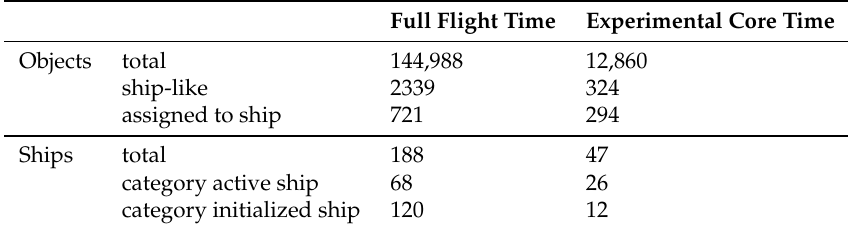
Table 8. Analysis of the results produced by the ship detection